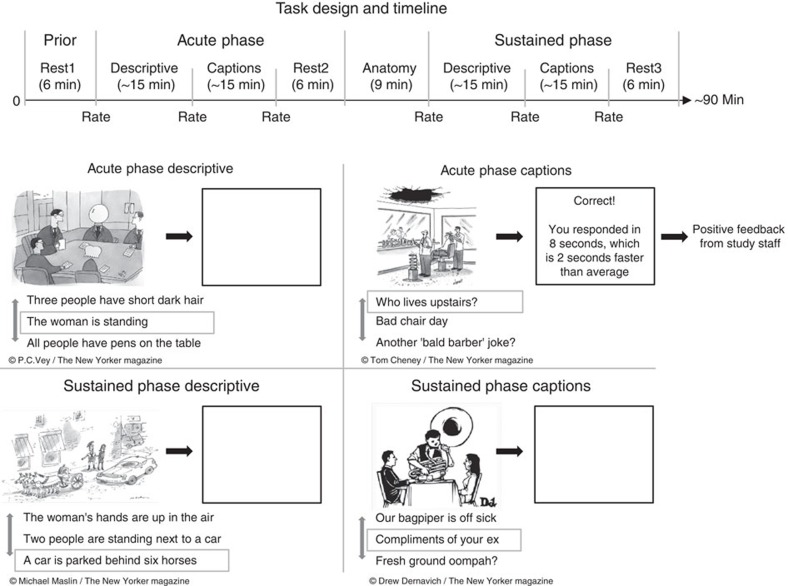
Task design and timeline.The task was composed of four phases: The Acute Descriptive phase, in which participants chose which of three suggested sentences best described a cartoon, without receiving any feedback. The Acute Captions Phase, in which participants chose, for each cartoon, which of three suggested humoristic captions won the New Yorker Caption Contest. In this phase, after 14 of their 18 selections, participants saw a screen indicating that they were correct and that they responded faster than average. Following completion of this phase, participants saw a short pre-recorded video in which an actor that presents himself as the director of research is attributing participants' excellent performance in the caption task to their evidently high levels of emotional intelligence and sense of humour (Supplementary Movie 1). Next, the Sustained Descriptive Phase and Sustained Captions Phase were presented, which are identical to the Acute Descriptive and Captions phases, respectively, with the exception that no feedback was given to participants at any point. In addition, three resting state scans were acquired (before the acute phase (rest 1); following the acute phase (rest 2); and following the sustained phase (rest 3)) to investigate the neural basis of spontaneous affect fluctuations in the absence of external stimuli. Finally, participants were asked to rate their current mood state at six time points throughout the task via a visual analogue mood scale (VAMS).